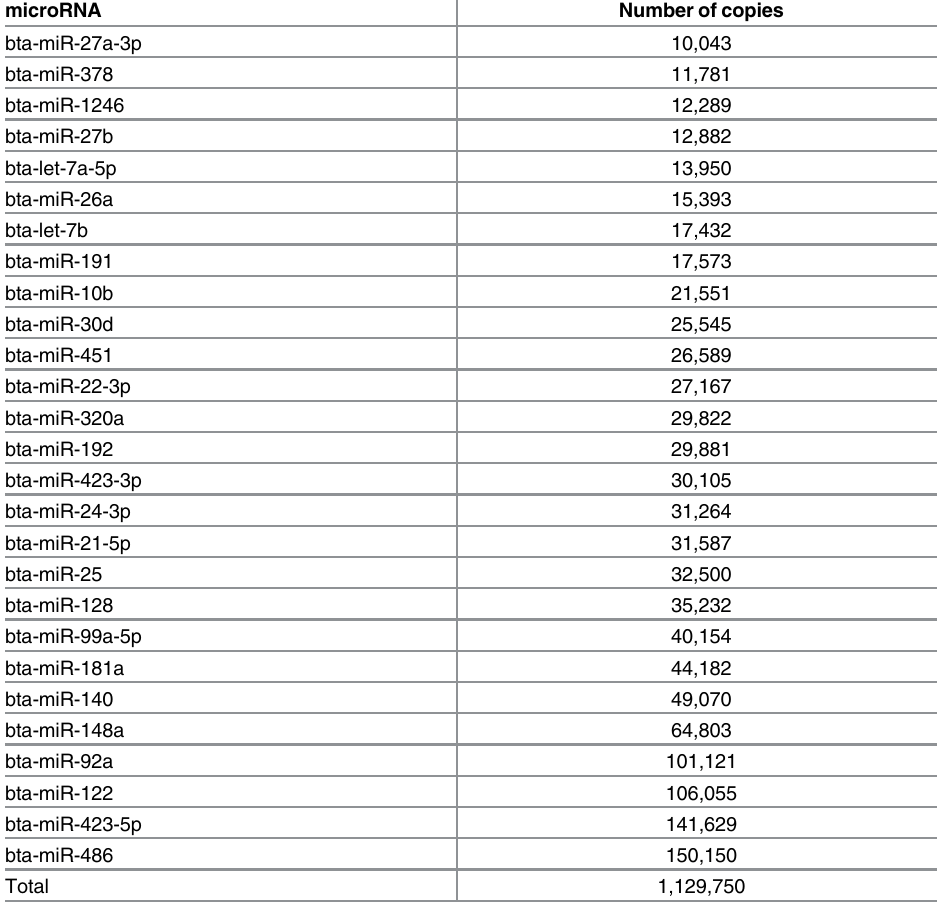
Table 1. Total number of copies for each microRNA in the